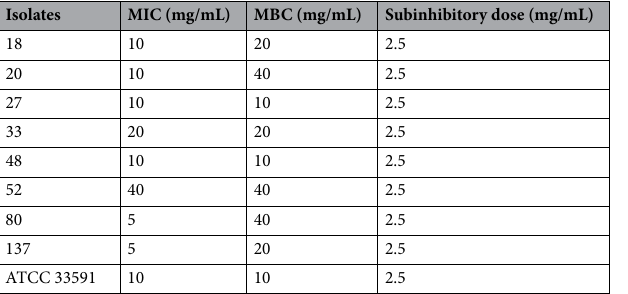
Table 1. MIC, MBC, and subinhibitory dose values for isolates of MRSA treated with citral. MIC minimum inhibitory concentrations, MBC minimum bactericidal